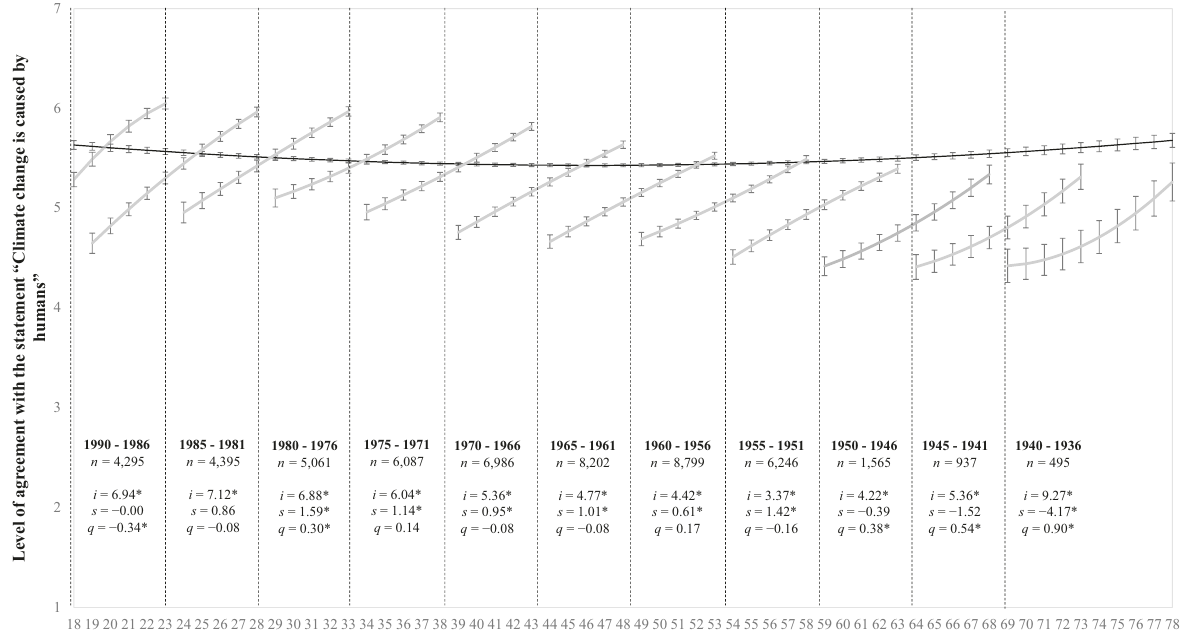
Fig. 1 Belief in the reality of climate change across age and fi ve-year birth cohorts. Model-implied change trajectories in the level of agreement with the statement “ Climate change is real ” (dark line) from ages 18 to 78. The lines within each 5-year cohort represent longitudinal change in climate reality, estimating latent intercepts ( i ) as well as linear ( s ) and quadratic ( q ) slopes. The estimations are based on the mean-levels of climate reality ( y -axis) across age and assessments ( x -axis) with 95% con fi dence intervals presented as error bars around each point estimate (* p < 0.05). Due to graphical space constraints, details for the 1995 – 1991 cohort are not shown but are: n = 3404, i = 6.00*, s = − 1.45, q = − 0.56*. Respondents expressed their levels of disagreement-agreement on a 7-point answer scale anchored by 1 (strongly disagree) and 7 (strongly agree).